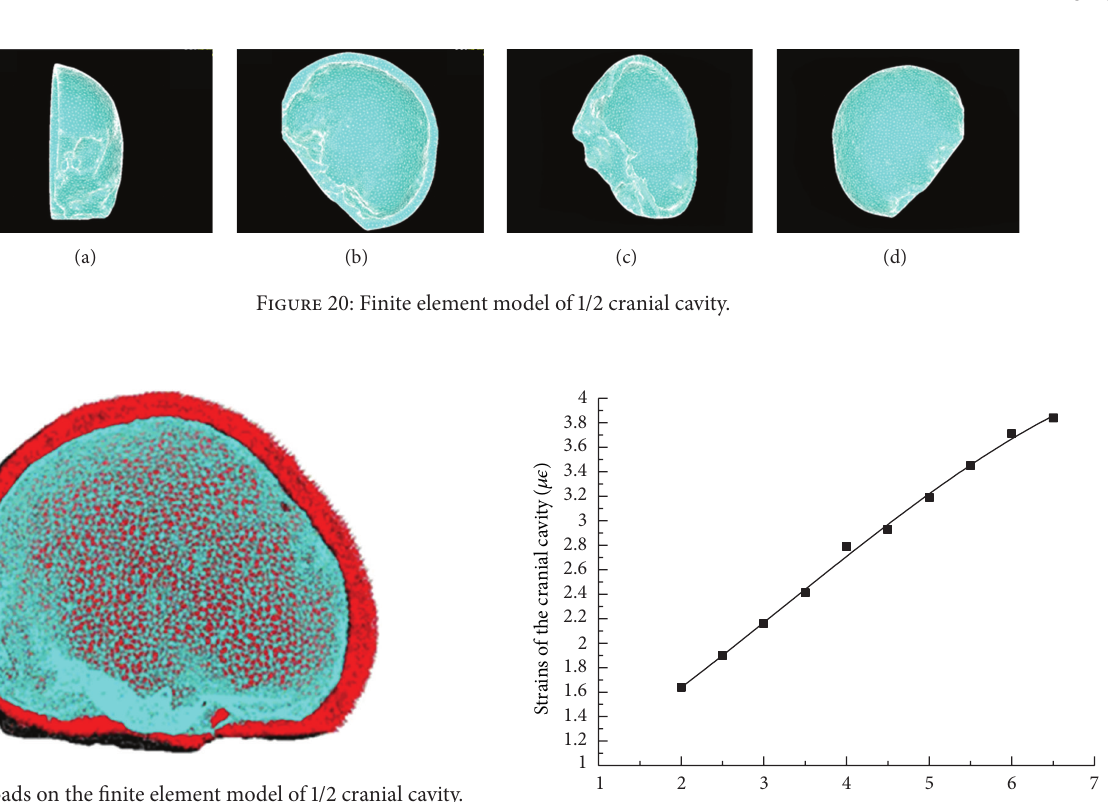
Figure 21: Loads on the finite element model of 1/2 cranial cavity.